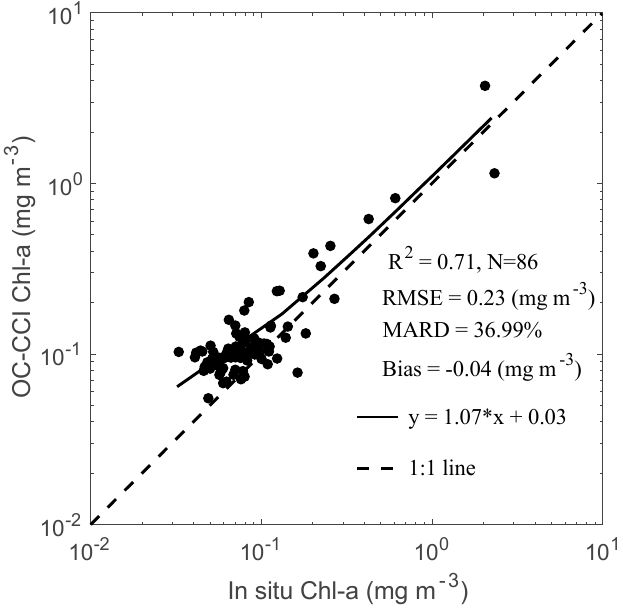
Figure 4. Correlation between Chl-a concentrations measured shipboard and those estimated from OC-CCI data for each hydrographic station. Selected criterium OC-CCI data were used, which were averaged within a 3 × 3 pixel box of daily satellite collocation. Owing to persistent cloud cover, the daily products resulted in no data being available for 47 of the 133 stations.